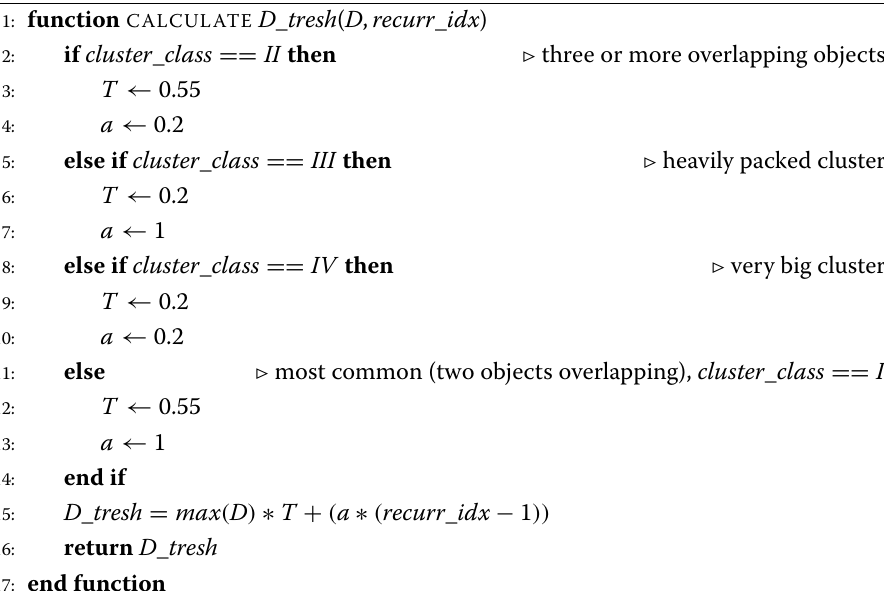
Algorithm 1 Calculation of the threshold value depending on the cluster